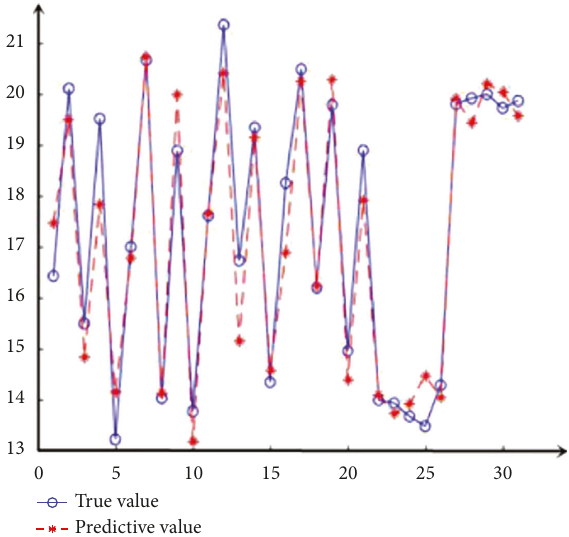
Figure 22: Volume shrinkage prediction error chart.